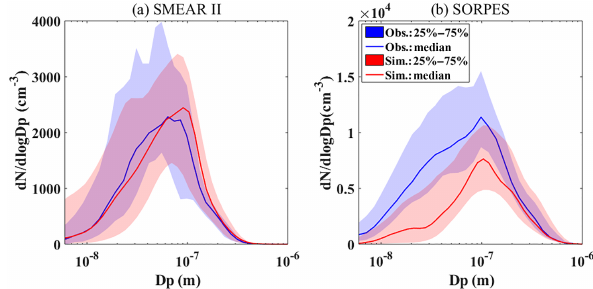
Figure 5. The observed and simulated aerosol number size distribu- tions (a) at SMEAR II and (b) at SORPES. Note the observed and simulated average (line) and ± 1SD (shaded area) are in blue and red,